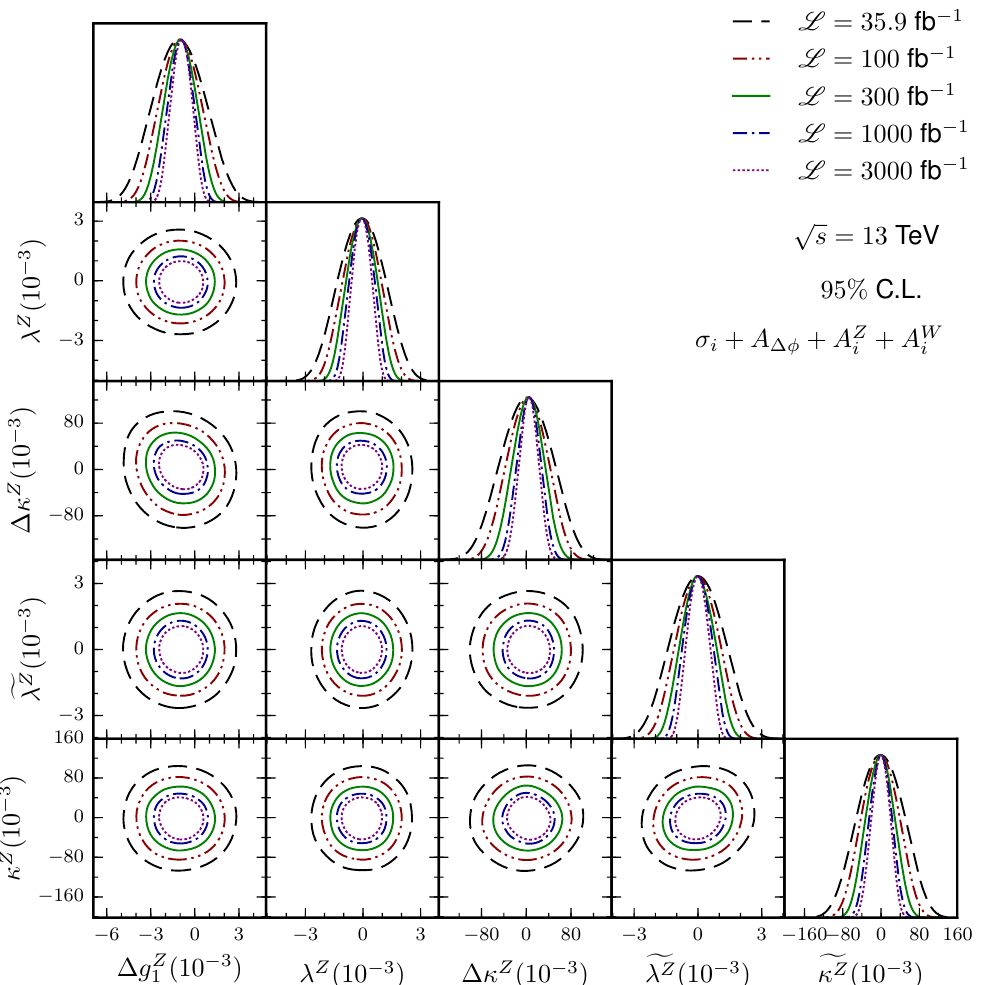
Figure 8 . All the marginalised 1 D projections and 2 D projections at 95 % BCI from MCMC in triangular array for the e(cid:11)ective vertices ( c L